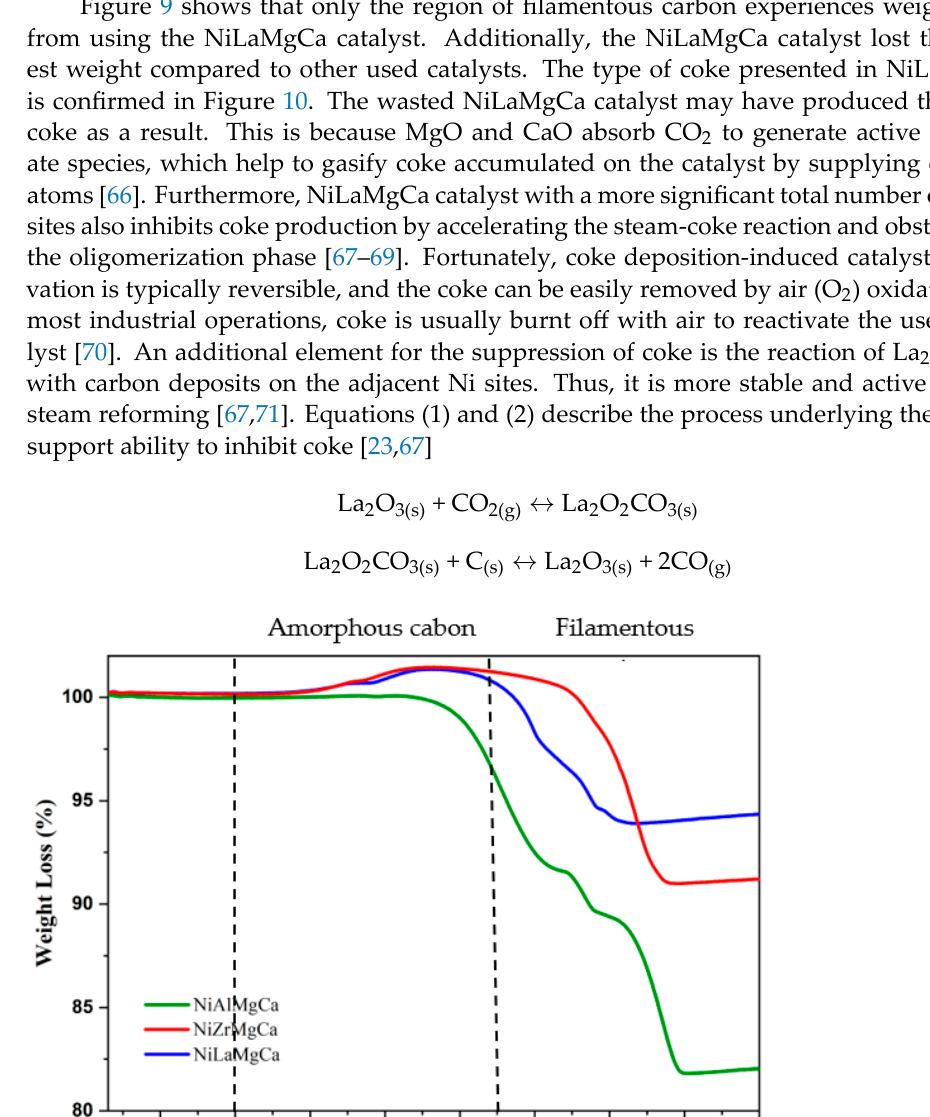
Figure 10. Field emission scanning electron microscopy (FE-SEM) of NiLaMgCa spent catalyst . Additionally, the Al 2 O 3 support strong acidity promotes the dehydrogenation of hydrocarbon into coke over metal phases, which causes the NiAlMgCa catalyst to lose weight. As a result, amorphous coke is deposited on the NiAlMgCa catalyst, which is why the catalytic activity is diminishing [23,72]. While both amorphous and filamentous carbon were seen on the spent NiAlMgCa catalyst, only filamentous carbon was evident on the spent NiLaMgCa catalyst, correlating with the result from the TGA analysis. The redox capability of the ZrO 2 support is responsible for the weight loss associated with filamentous coke deposited on the NiZrMgCa spent catalysts [20,23,73]. The reac- tions described in Equations (3) and (4) are redox reactions, which imply that electrons were transferred from one species to another. In steam reformation, the water dissociates on the oxygen vacancies on the support, forming an oxygen lattice. Next, the generated oxygen lattices expanded into the Ni sites to help prevent coke formation [23,74]. Below are the reversible process (Equation (3)) and coke removal reaction (Equation (4)). MO 2 ↔ MO 2 − x(s) + O 2 (g)